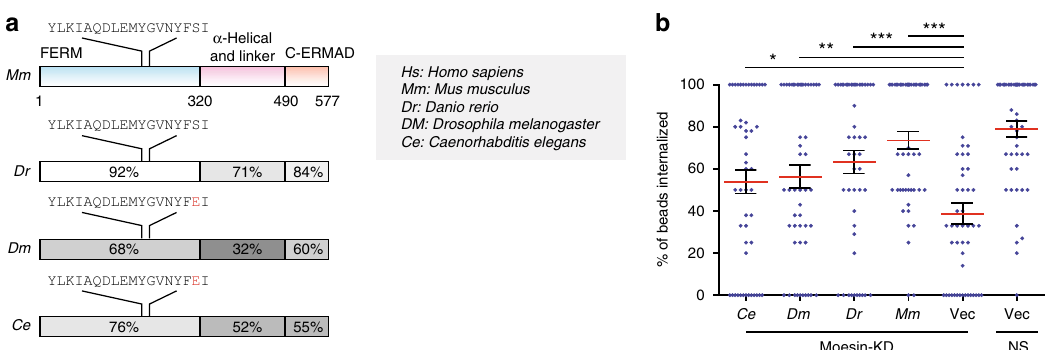
Fig. 6 Moesin function is conserved in solid structure phagocytosis. a Schematic of Moesin proteins in Mus musculus (Mm), Danio rerio (Dr), Drosophila melanogaster (Dm), and Caenorhabditis elegans (Ce) , identi fi ed by NCBI Blast search. Functional domains and sequences of ITAM motif are shown. Two-letter abbreviations of all the listed species presented in this fi gure are shown on the left. b Moesin KD DC2.4 cells were rescued with the molecules indicated in a by transient overexpression. Vector transfection of the KD and WT cells were also shown. n = 50, N = 3. * p < 0.05, ** p < 0.01, and *** p < 0.001 by one-way ANOVA with Scheffé post